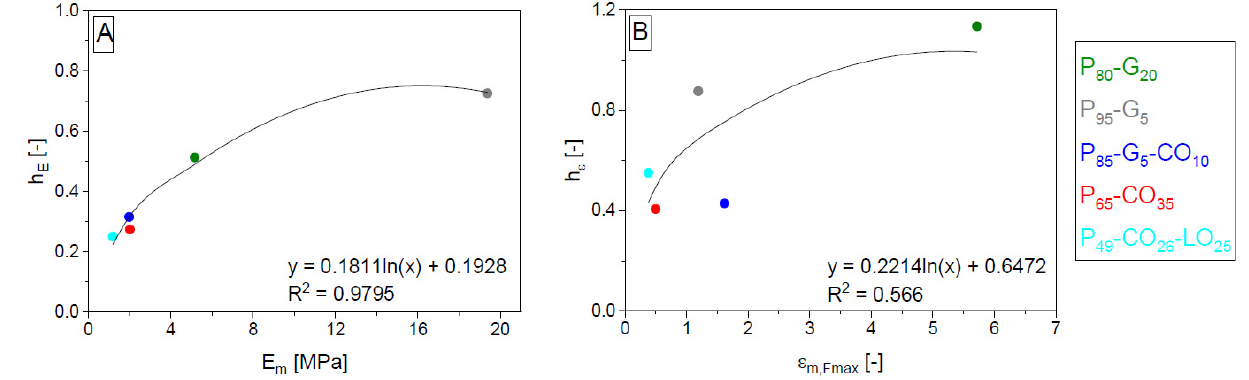
Figure 3. Dependences corresponding to relations (25) ( A ) and (28) ( B ). The symbol h with subscript labeling the property is the slope of dependence describing the correction parameter η in the mixing rule. The symbol h is here described by polyurethane matrix properties. Matrices designation is composed of components labeled P (polyurethane pre-polymer), G (glycerol), CO (castor oil), and LO (linseed oil). Numbers (subscripts) mean vol. % of matrix components.